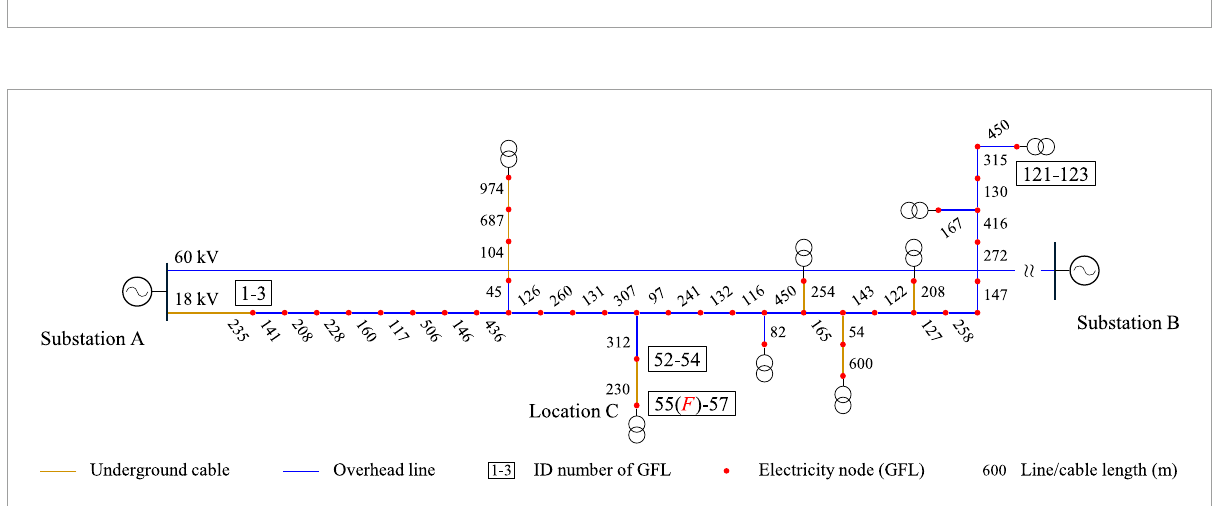
FIGURE 4 (A) Schematic description of the field experimental set-up configured using a 677-m long 10-kV overhead line spanning 11 towers (numbered 22–32). At the two terminal towers, the overhead lines were grounded through lumped capacitors (e.g., C 0 a to C 0 c ), which were designed to emulate high-frequency impedance of power transformers. (B) Picture of Tower No. 23, where a pulse generator (marked with the red circle) was connected to one of the phase conductors [adapted from (Wang et al. (2018a)].